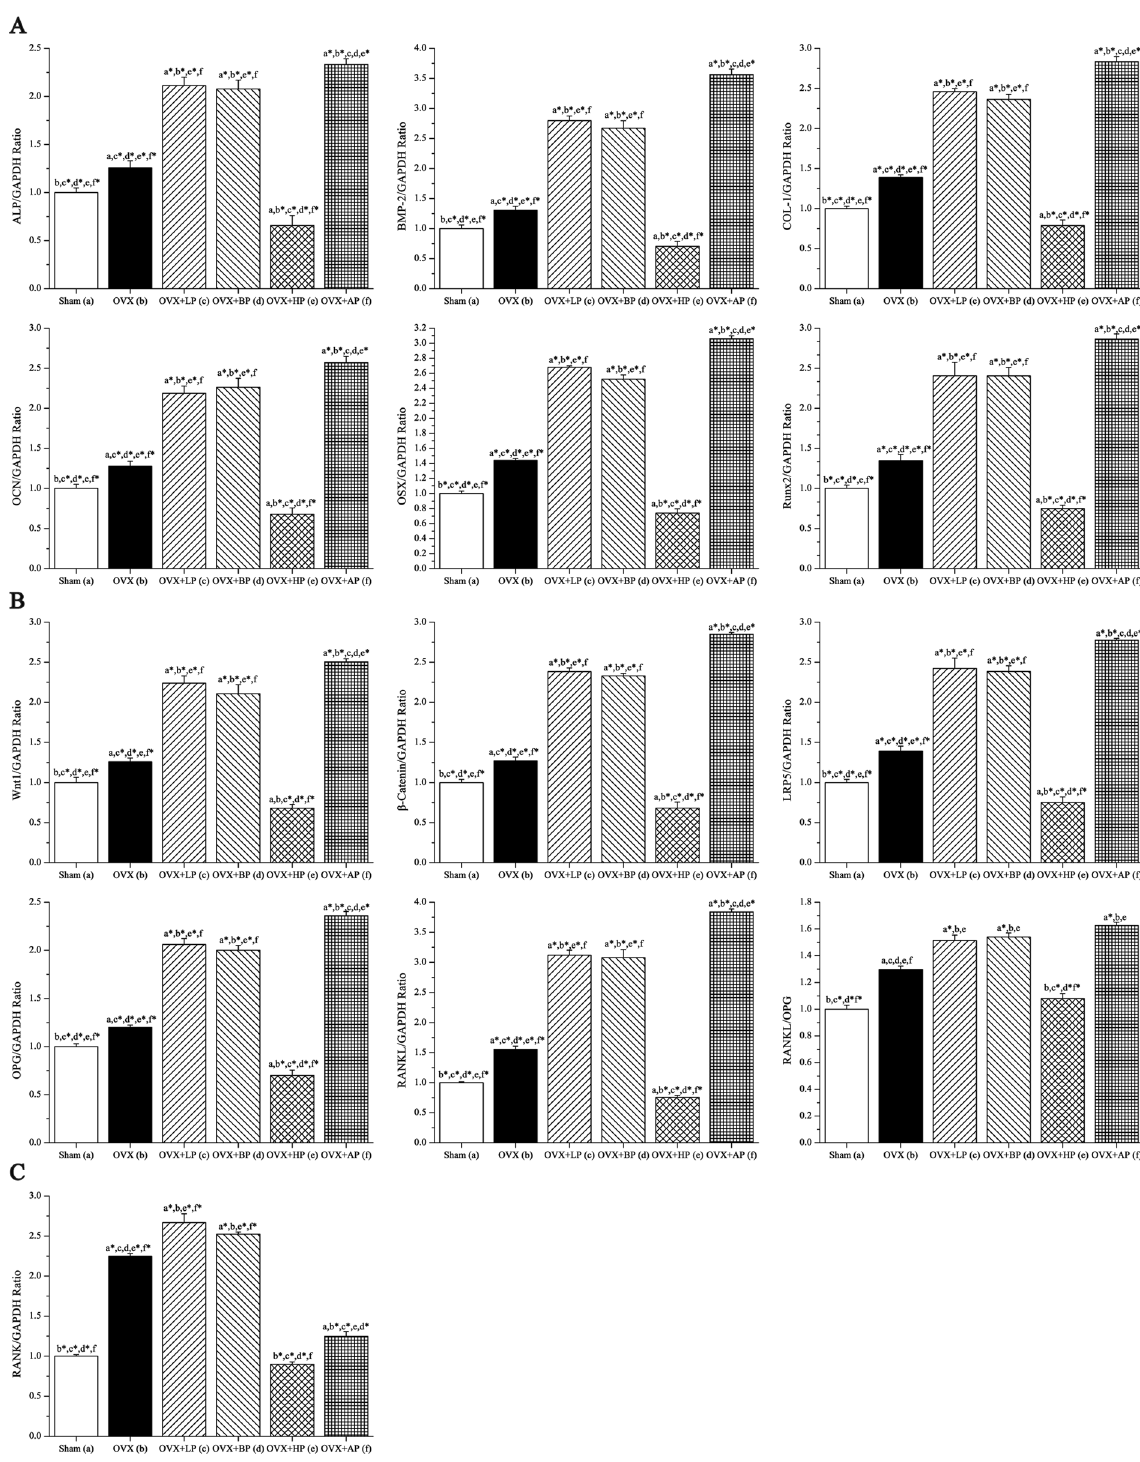
Figure 10. Effects of 8-week EMF exposure on gene expressions in the humerus with the removal of bone marrow in OVX mice by real-time fluorescence quantitative PCR analysis, including ( A ) osteogenesis- related gene expressions ( B ) Wnt1/ β -catenin/LPR5 and OPG/RANKL signaling gene expression ( C ) osteoclastogenesis-related gene expression. Values represent mean ± SD of 8/group. Letters a-f indicate differences between respective groups at P < 0.05 or * P < 0.01 (a versus Sham; b versus OVX; c versus OVX + LP; d versus OVX + BP; e versus OVX + HP; f versus OVX +